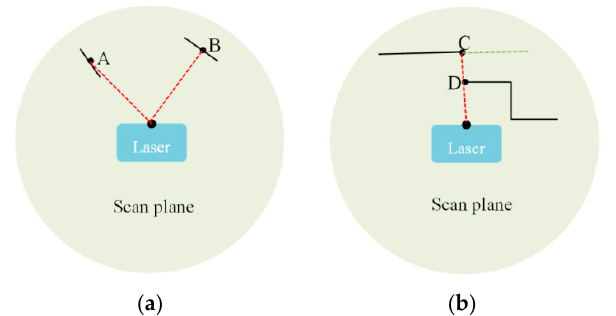
Figure 2. The black solid lines are the local surface patches of feature points; the red dotted lines are the laser beams; the green dotted lines represent the occluded region. ( a ) The direction of point A’s local surface patch is almost parallel to the laser beam, so the location accuracy of point A is very limited; ( b ) There is a gap between point C and point D, so point C may be occluded in the next scan. Point A and point C are both rejected as unreliable feature points in our approach.